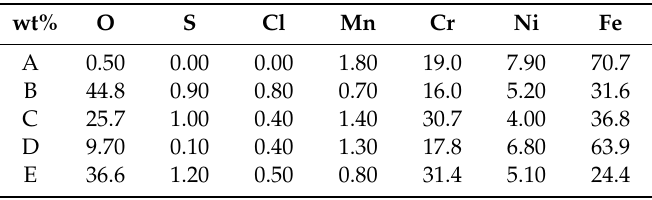
Figure 6. Energy dispersive X-ray spectrometer (EDS) analysis results of the corroded region after 5000 h tests with 1 g / m 2 chloride concentration and relative humidity of 45%. Table 3. EDS analysis results of the corroded